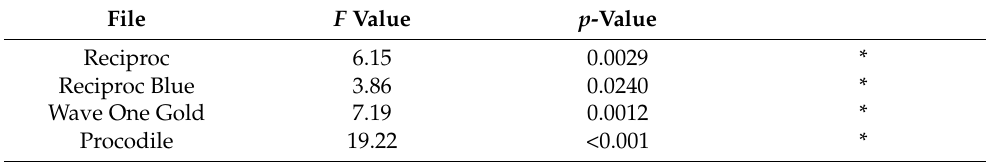
Table 1. Comparison between interactions between type of file and movement (* = p value < 0.05). File